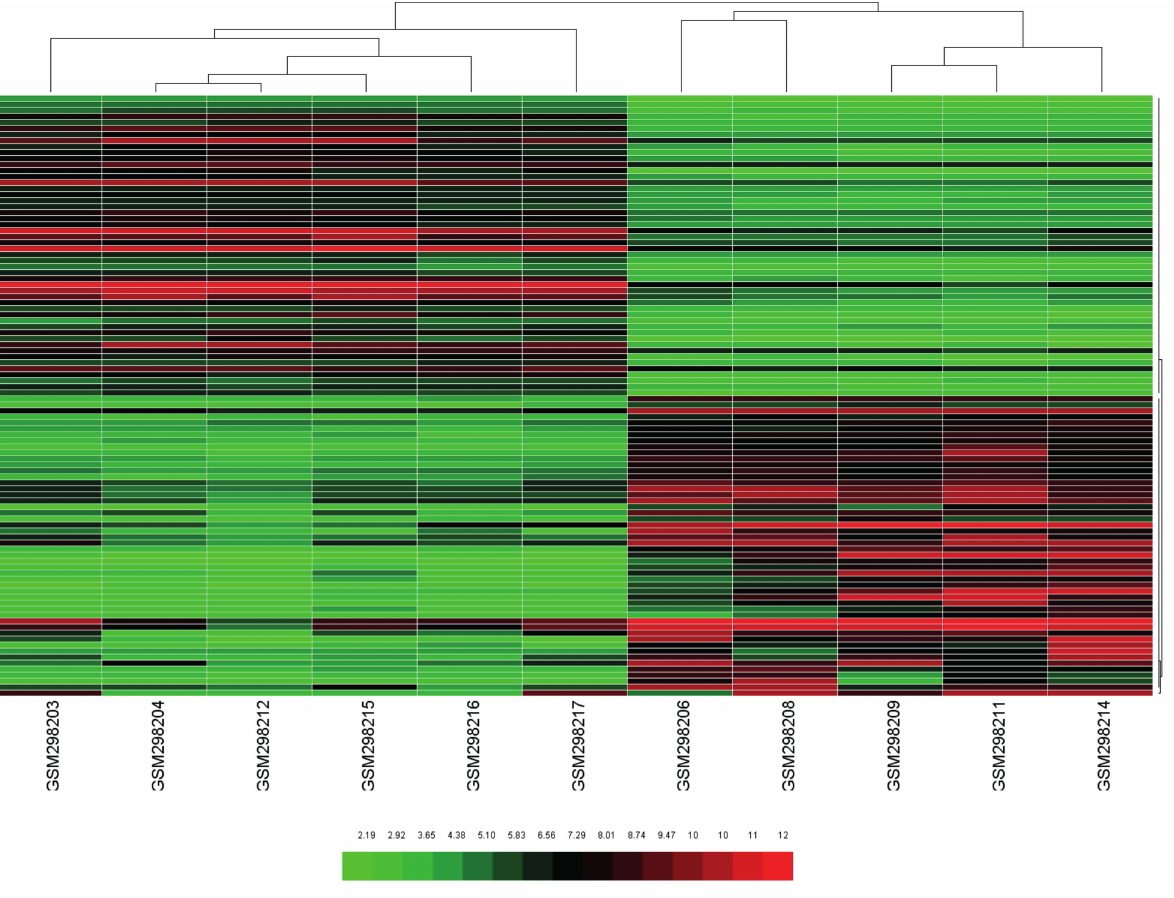
Figure 2 - The heatmap of top fifty up-regulated genes and top fifty down-regulated